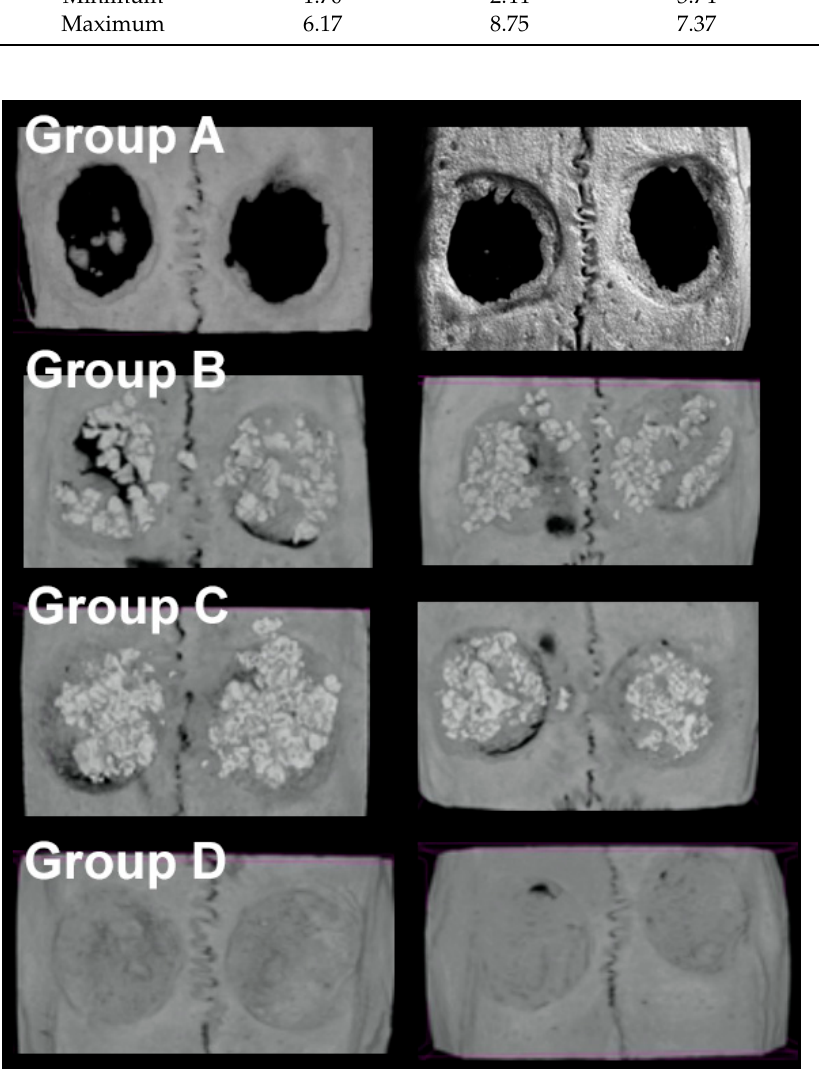
Figure 3. 3D reconstructions of the micro ‐ CT showing the results of two examples of each group. Transplantation of Spongostan™ results in significantly increased mineral density of the new bone compared to NanoBone ® and Actifuse. Group A—the control group; Group B—NanoBone ® ; Group C—Actifuse; Group D—Spongostan™.